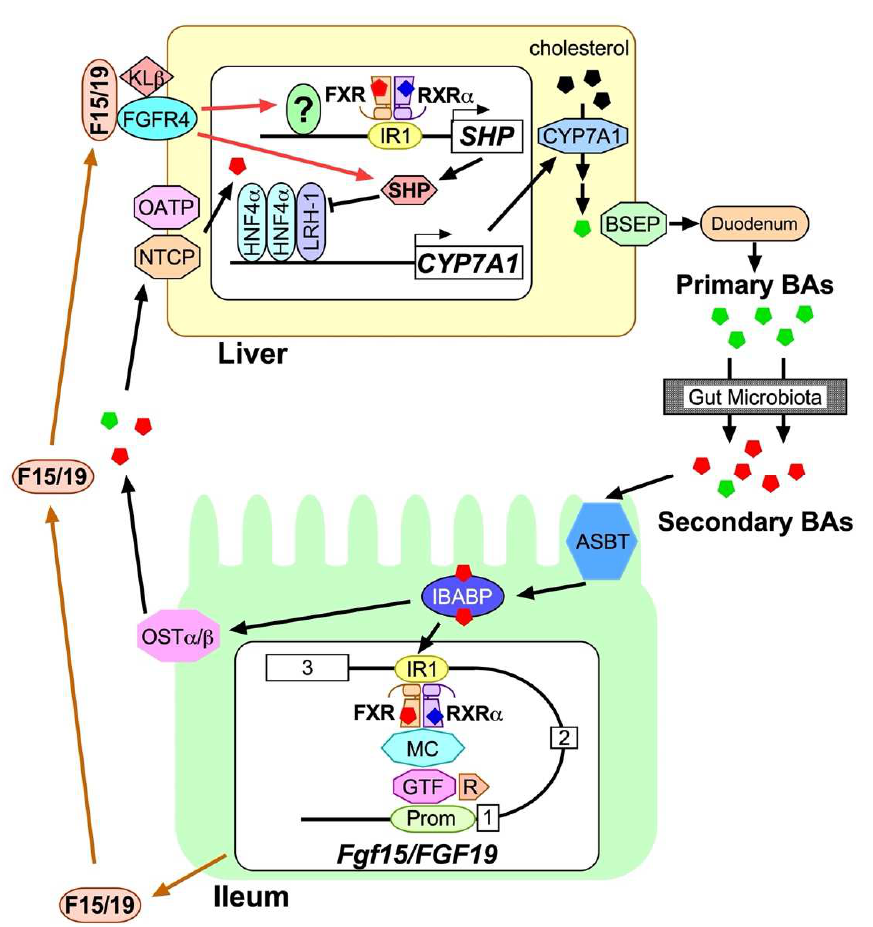
Figure 5. Regulation of BA synthesis by FXR-FGF15/19 signaling axis. Primary BAs (green penta- gons) are synthesized from cholesterol (black pentagons) by a series of enzymatic reactions initiated with CYP7A1 in hepatocytes, and are exported from hepatocytes through BSEP, delivered to the